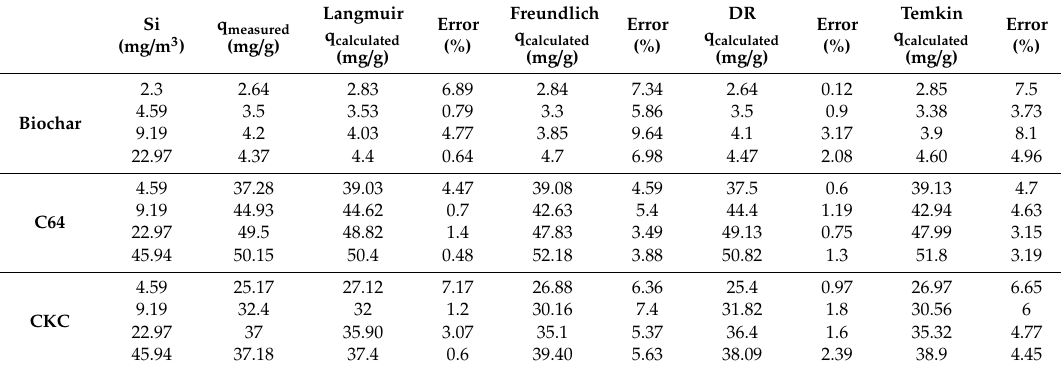
Figure 3. Langmuir isotherm for D4 removal with biochar, C64 and CKC. AC, activated carbon. Table 4. Adsorption capacity estimated with isotherms for